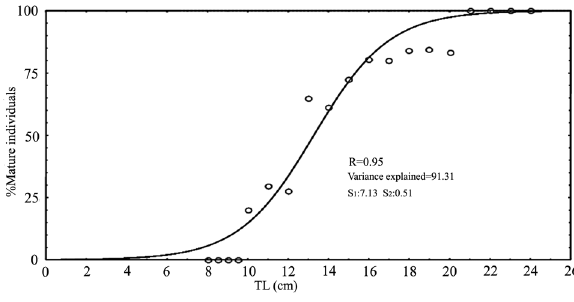
Fig . 2. – Size at maturity of Citharus linguatula . Points represent the percentage of mature individuals for each size class.